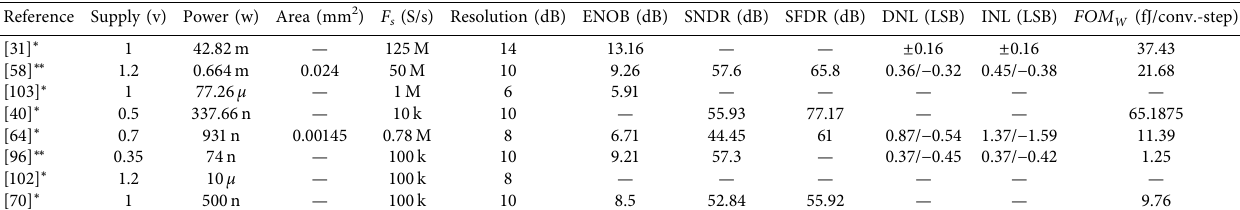
Table 6: Summary of the recently published SAR ADC performance parameters in 90nm